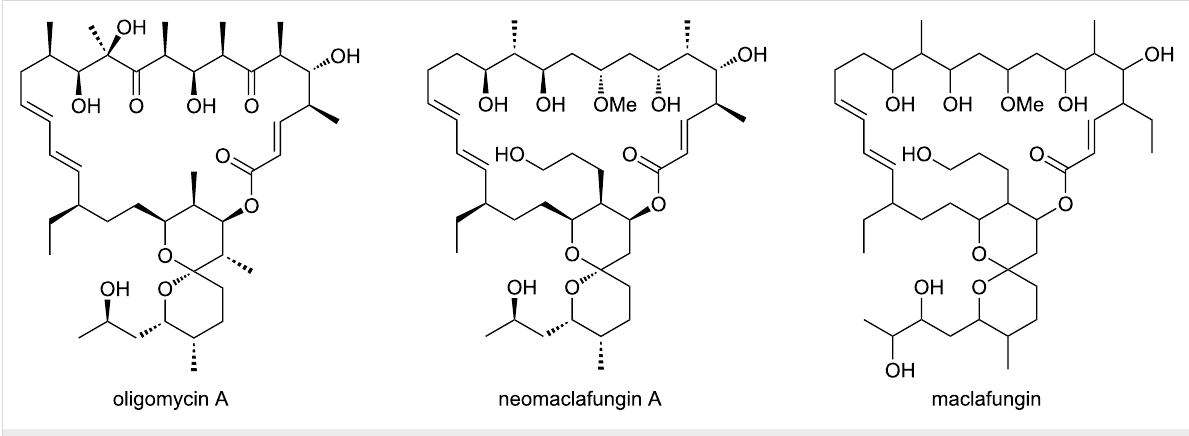
Figure 8: Selected examples of oligomycin-class metabolites from actinomycetes.